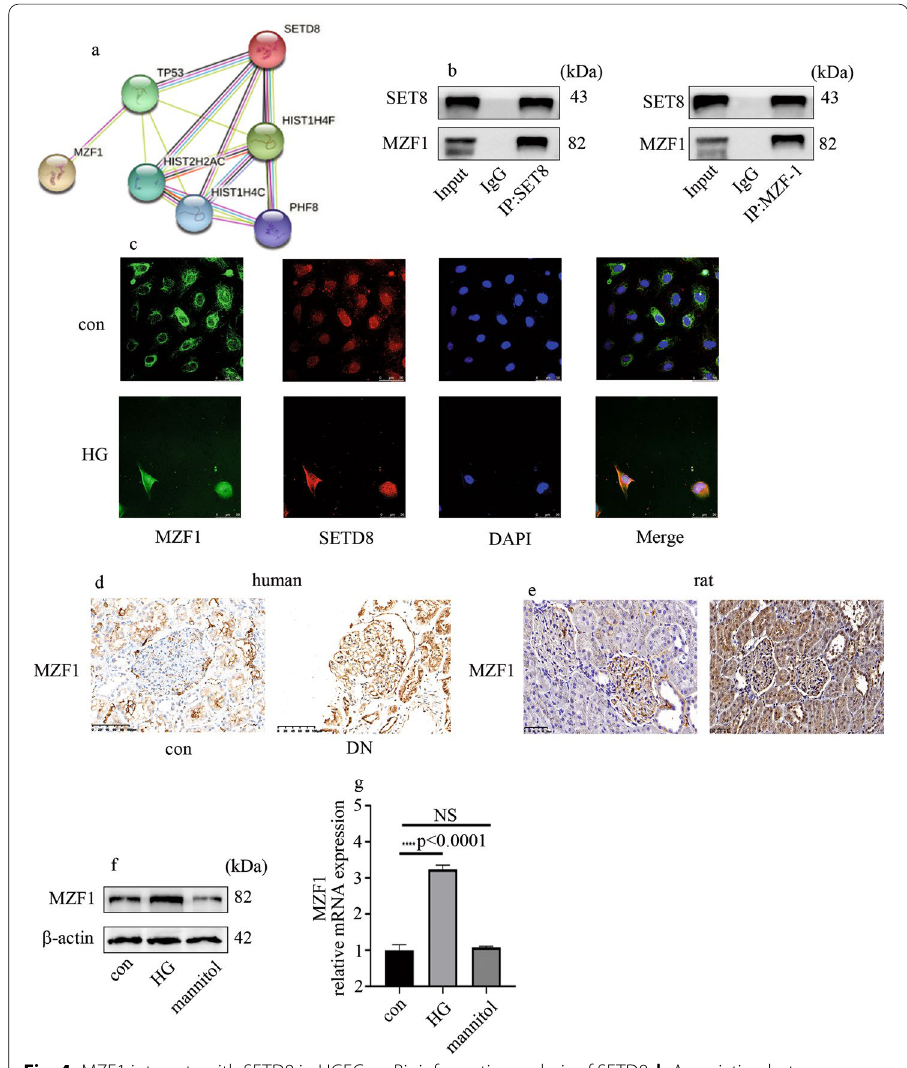
Fig. 4 MZF1 interacts with SETD8 in HGECs. a Bioinformatics analysis of SETD8. b Association between SETD8 and MZF1 verified by CoIP. c Colocalization of MZF1 and SETD in HGECs. d, e IHC expression of MZF in human and rat. f, g Protein and mRNA levels of MZF1 in HGECs (* p < 0.05, ** p < 0.01, *** p < 0.001, **** p < 0.0001, n 5 per =